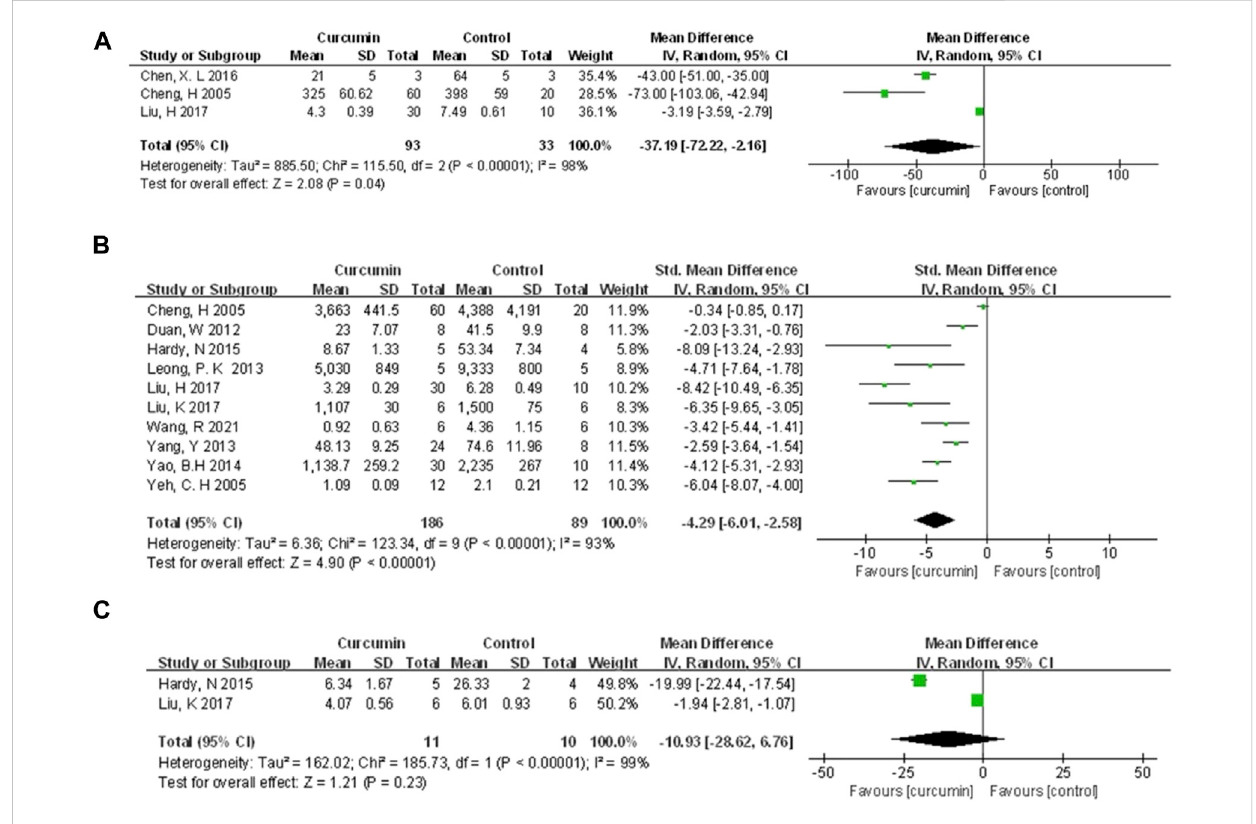
The meta-analysis results of the effect of curcumin on (A) CK-MB (B) LDH, and (C)